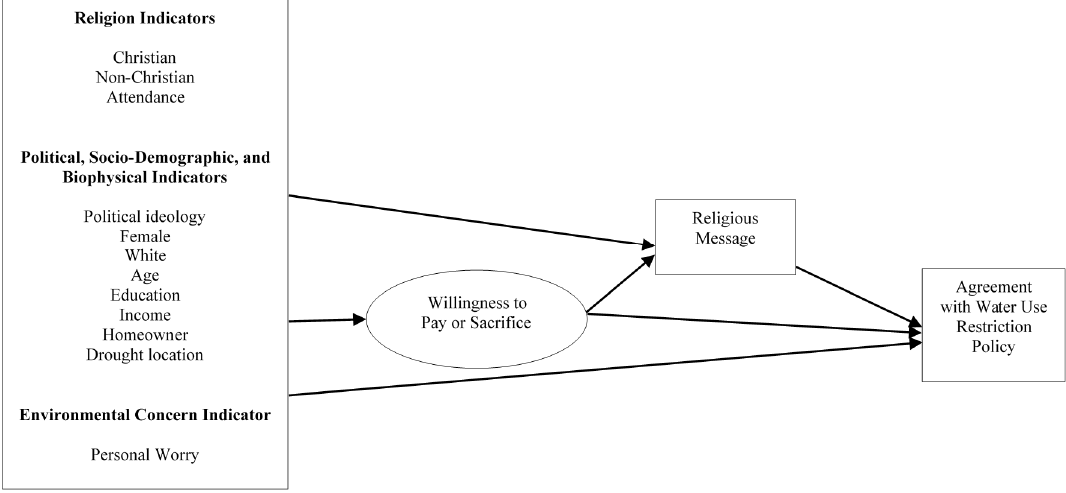
Figure 1. Analytical model.